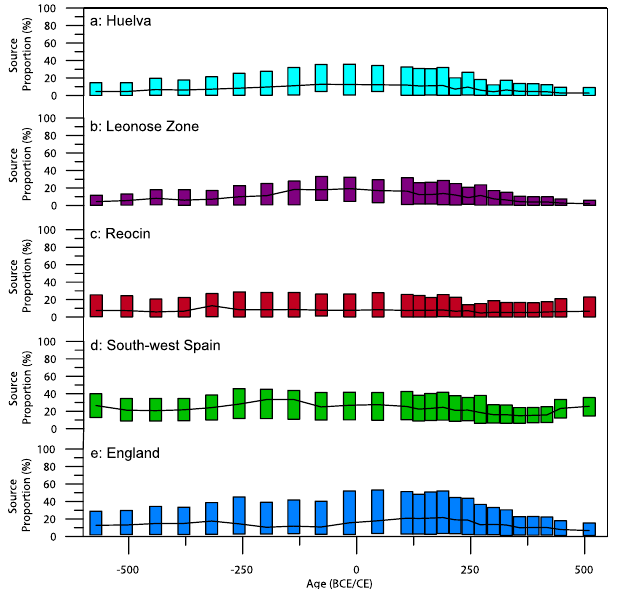
Figure 5. Model output from Penido Vello between 600 BCE and 550 CE, displaying the contribution of selected mining regions to the Pb mixture recorded in the sediments through this period. Again, rectangles indicate upper and lower bounds as in Fig. 3, with black lines indicating the